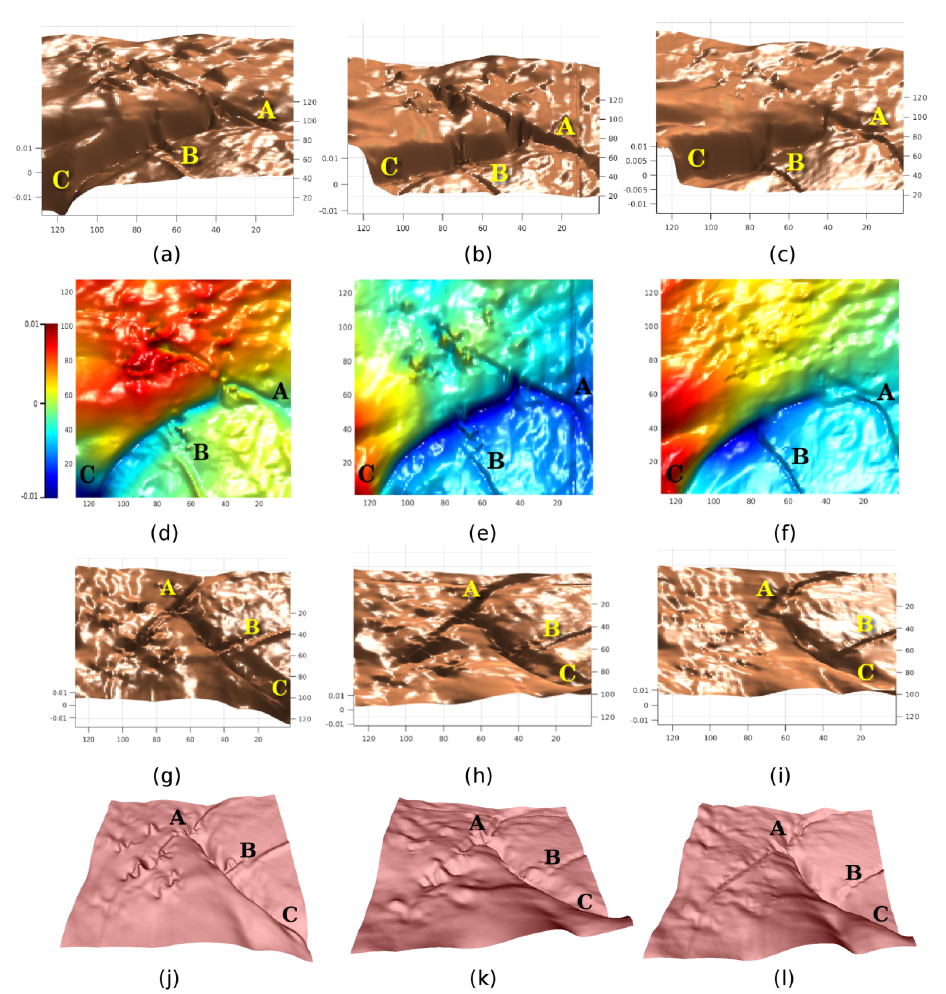
Fig. 15 Depth reconstruction results from real world endoscopy images. First column: using a Lambertian model. Second column: using a Blinn–Phong model with PPS. Third column: using a Blinn–Phong model with PPN. All images are shown using an identical view to visualize differences. Once more, the deviations in Lambertian outcomes is clear, whereas our approach provides a trustable 3D reconstruction without